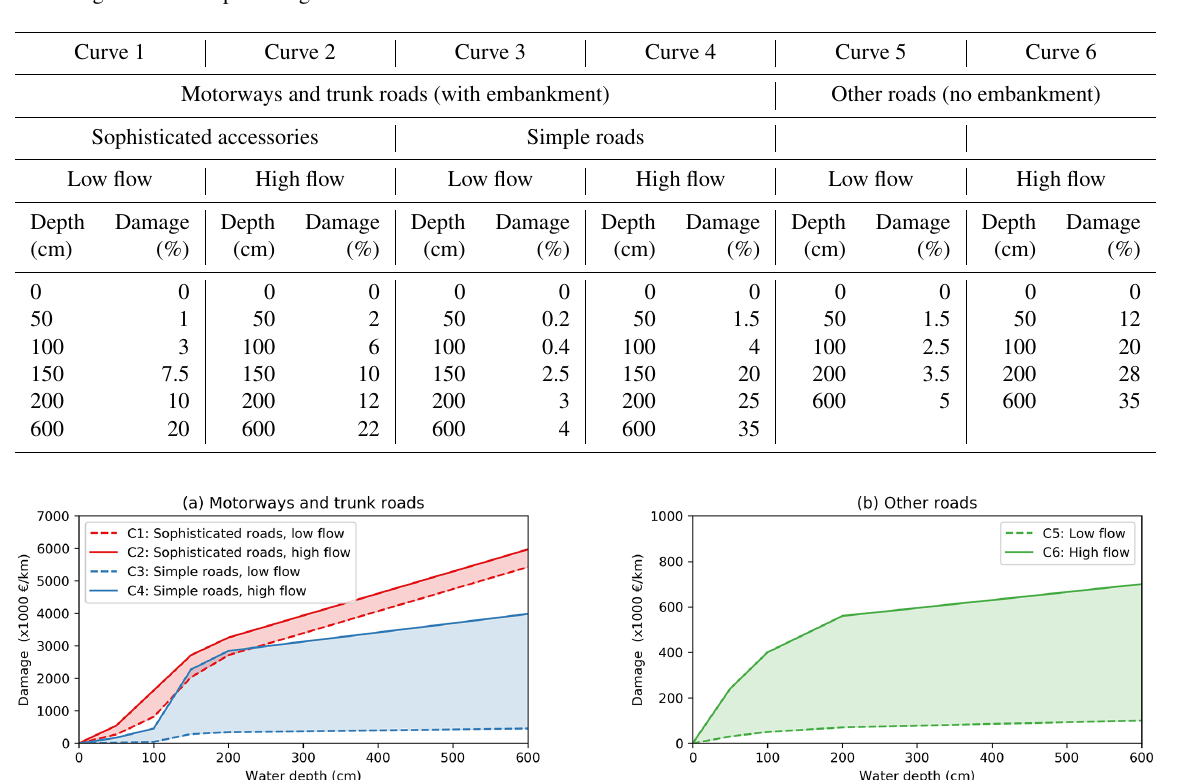
Table 2. Damage curves as a percentage of road construction costs.